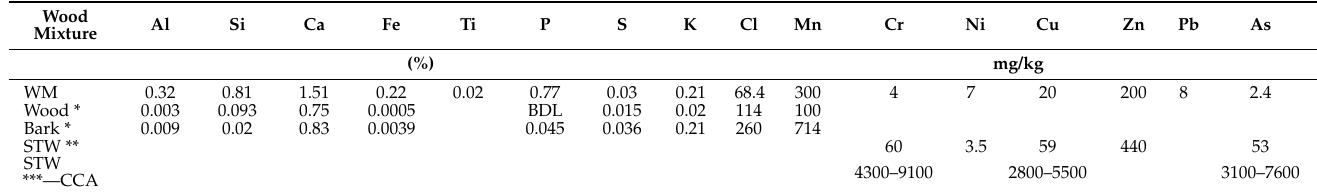
Table 5. Content of inorganic elements in WM, wood and wood treated with preservative (literature data). Wood